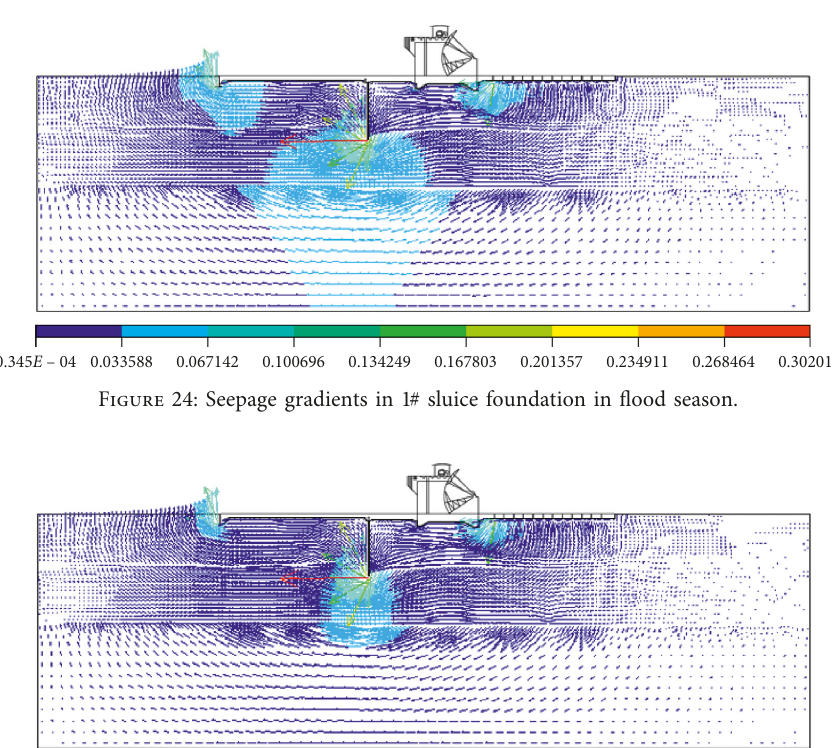
Figure 23: Total seepage head contour in 2# sluice foundation in dry season.